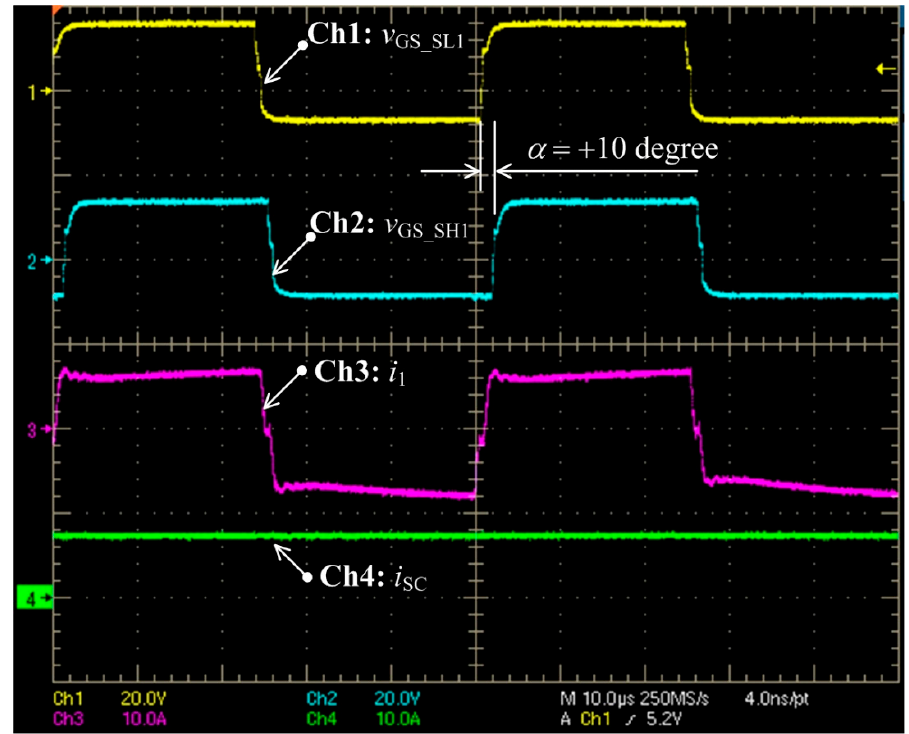
Figure 16. Experimental results: switching waveforms of the DAB converter at v FC = 86 V, V SC = 20 V, p SCd = 150 W (at α = + 10 degree), discharging the SC storage device. To present FC voltage regulation in an interval ( V FCMin = f ( P FCMax ), V FCMax = f ( P FCMin = 0)) by using